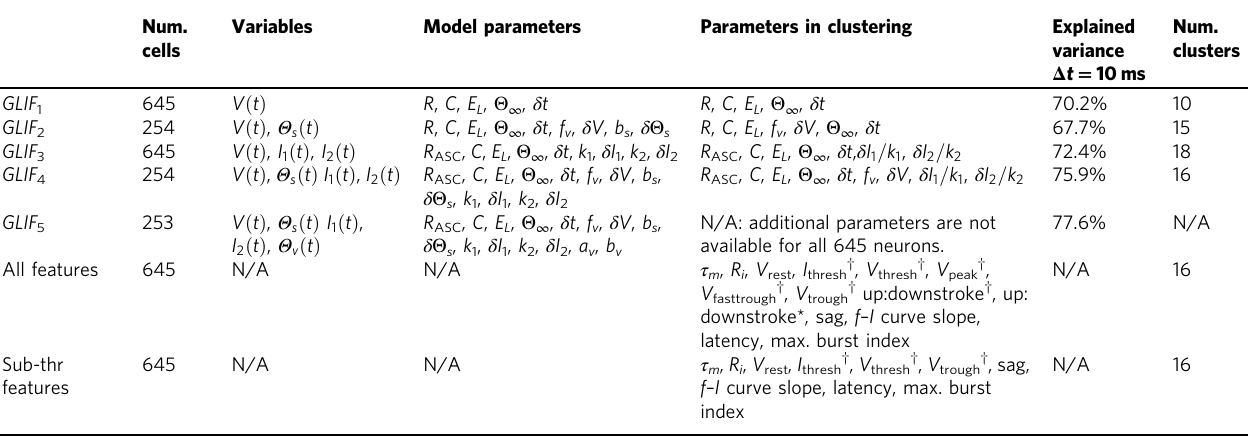
Table 2 Summary of GLIF models and results Num.